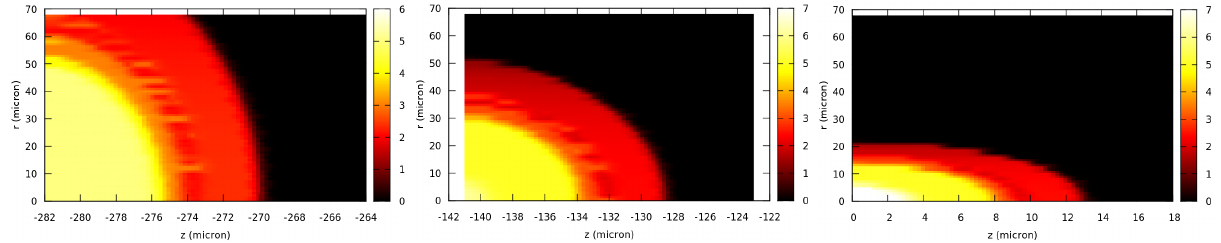
Figure 11. Ionisation map of N with the laser pulse at two Rayleigh ranges before the best focus ( left ), at one Rayleigh range ( centre ) and at the best focus position. The graph shows that full ionisation in N occurs well before the pulse enters the focal